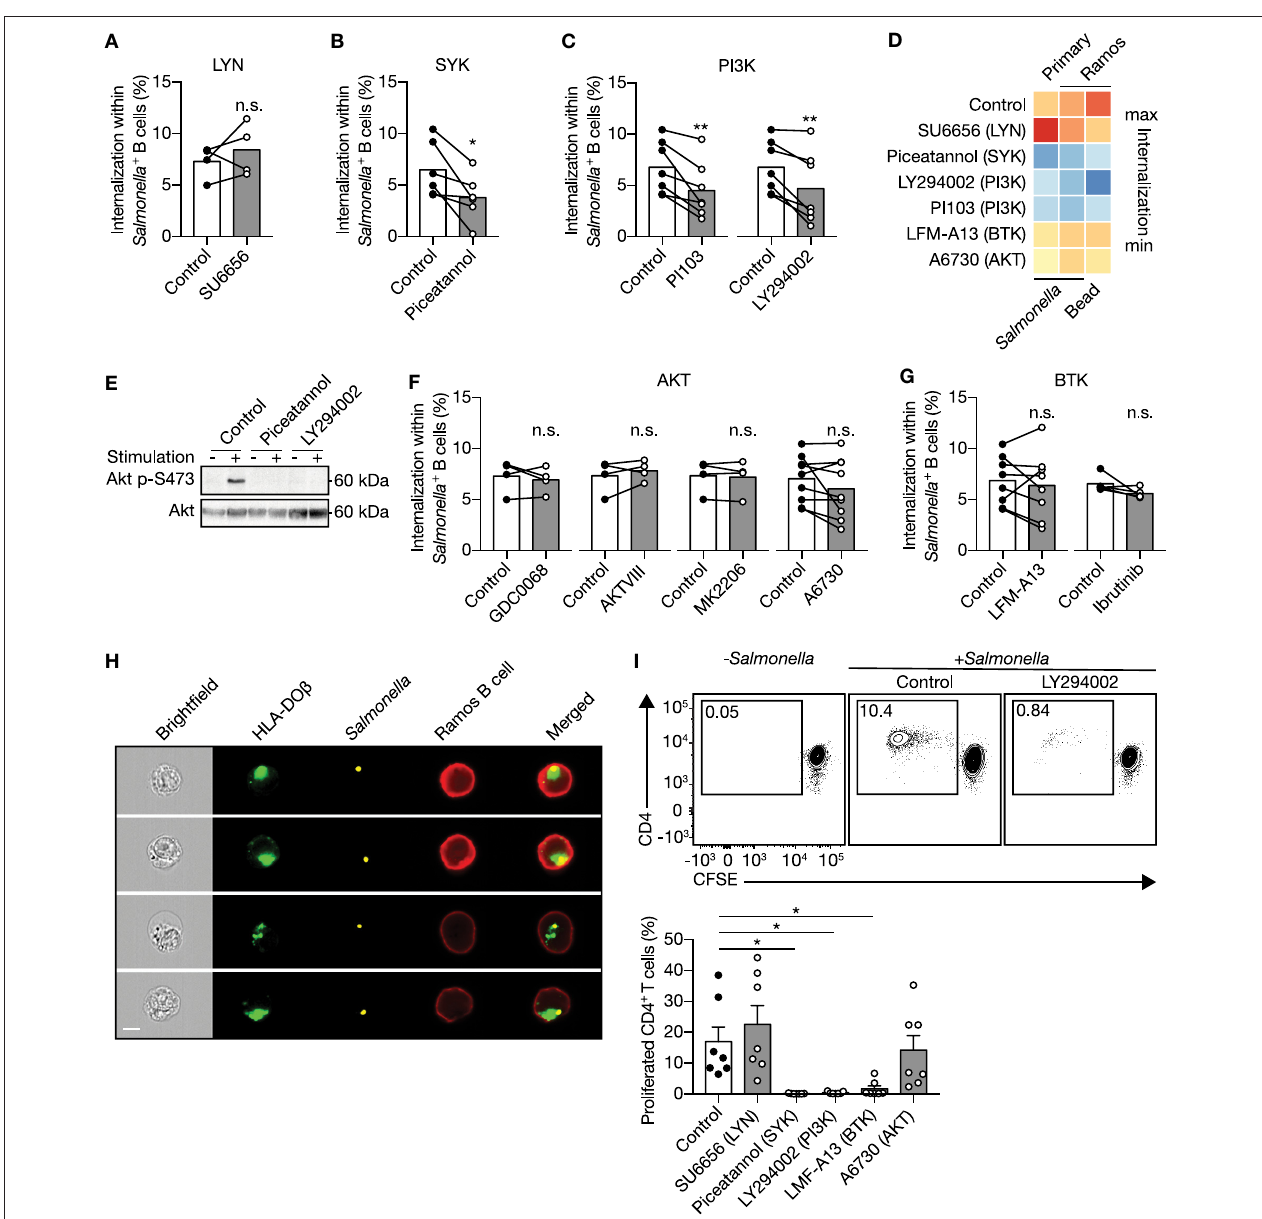
FIGURE 2 | IgM - BCR-mediated signaling through SYK and PI3K facilitate large particle internalization. (A–C) Proportion of internalization within S. typhimurium + primary human B cells after treatment with inhibitors of LYN [ (A) ; n = 4], SYK [ (B) ; n = 6] or PI3K [ (C) ; n = 7]. (D) Heatmap of the mean proportion of internalization within S. typhimurium + or 3 µ m polystyrene bead + primary human B cells and Ramos B cells after treatment with inhibitors of LYN, SYK, PI3K, BTK, or AKT. Heatmap colors indicate effect on internalization. (E) Immunoblot of whole cell extracts from Ramos B cells that were unstimulated ( − ) or stimulated ( + ) with S. typhimurium after incubation with inhibitors of SYK (Piceatannol) or PI3K (LY294002). The blots were probed with specific antibodies for pAKT at S473 and AKT. (F,G) Proportion of internalization within S. typhimurium + primary human B cells after treatment with inhibitors of AKT [ (F) ; n = 4 and 9] or BTK [ (G) ; n = 8 and 5]. (H) Representative images of Ramos B cells expressing GFP-tagged HLA-DO β having internalized S. typhimurium. S. typhimurium -containing phagosomes localize to the HLA-DO β -containing MHC class II-antigen loading compartments. Bar, 7 µ m. (I) Representative plots (top) and quantification (bottom) of the proportion of proliferated CD4 + T cells after co-culture with S. typhimurium- primed autologous primary human B cells that were treated with inhibitors ( n = 7). All data points represent the mean of an individual experiment with duplicate measurements. Error bars indicate SEM. * P < 0.05; ** P < 0.01; n.s., not significantly different by paired t test (A–C, F, G) or repeated-measures one-way ANOVA with Dunnett’s post-test (I)